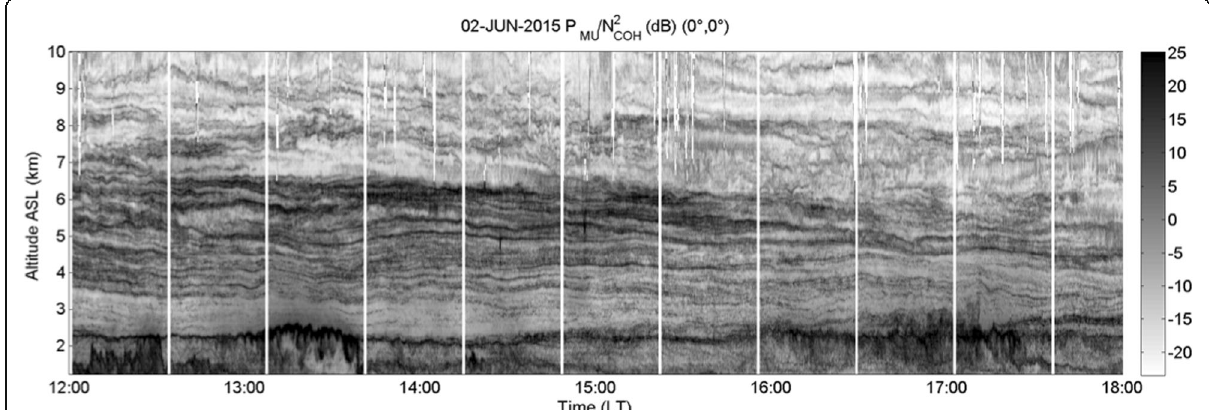
Fig. 1 MU radar echo intensity as a function of altitude (in km ASL) and local time (in hours) on June 2, 2015, from around 12:00 to 18:00 LT during the ShUREX 2015 campaign. The image was processed using the Capon method, with the radar operated in the range-imaging mode on the vertical beam. The scale on the right-hand side is in decibel. The striking feature of this radar image is the appearance of S&L fine structures which appeared around 09:00, persisting for more than 8 h till around 17:00 LT. In the lower part, the top of the convective boundary layer, with associated plume activity, can be seen at a height of around 2 km